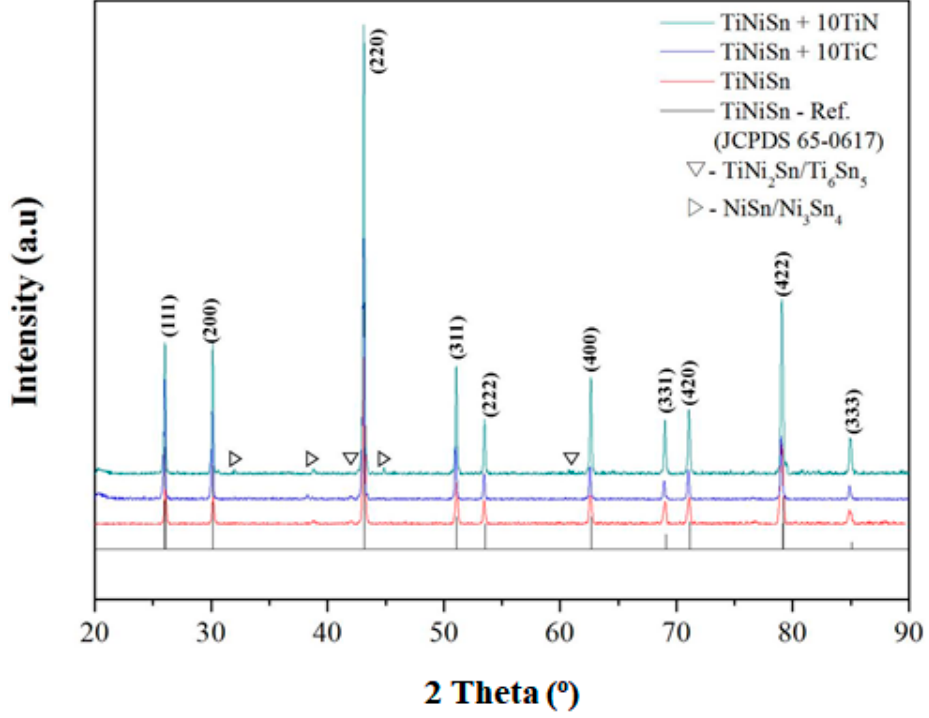
Figure 1. XRD (X-ray diffraction) patterns of arc-melted and annealed TiNiSn samples with the nominal compositions of TiNiSn, TiNiSn-10TiN, and TiNiSn-10TiC.